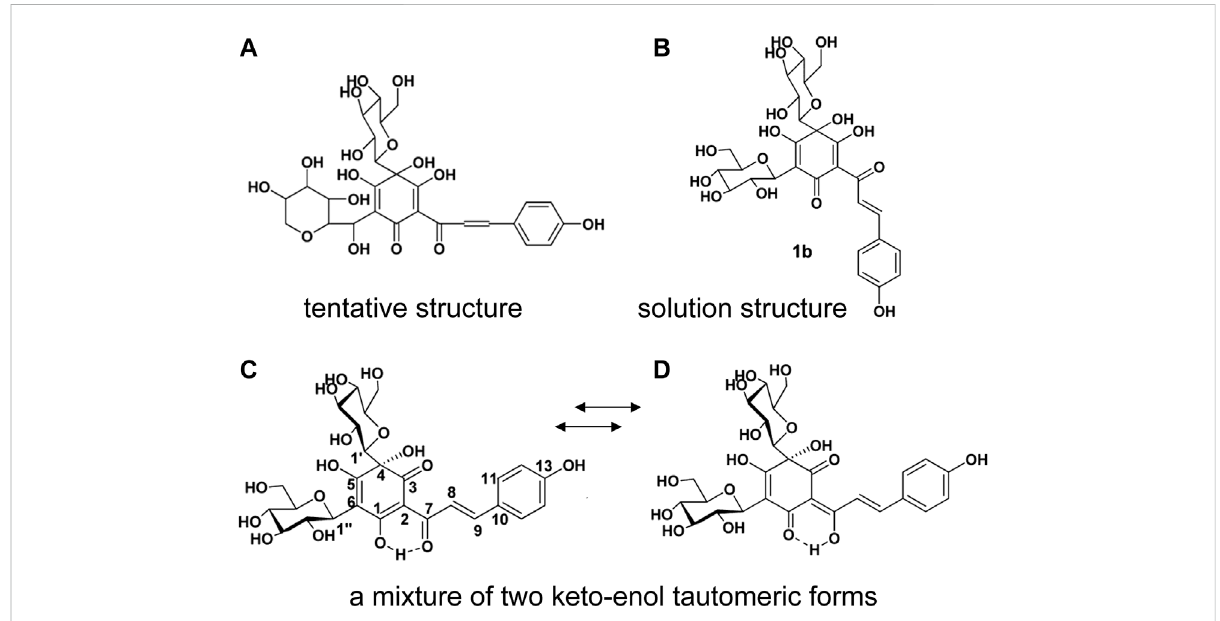
FIGURE 2 The structure of HSYA. (A) The tentative structure identi fi ed by Onodera et al., 1981, (B) the structure identi fi ed by Meselhy et al., (C, D) the structure identi fi ed by Feng et al.,